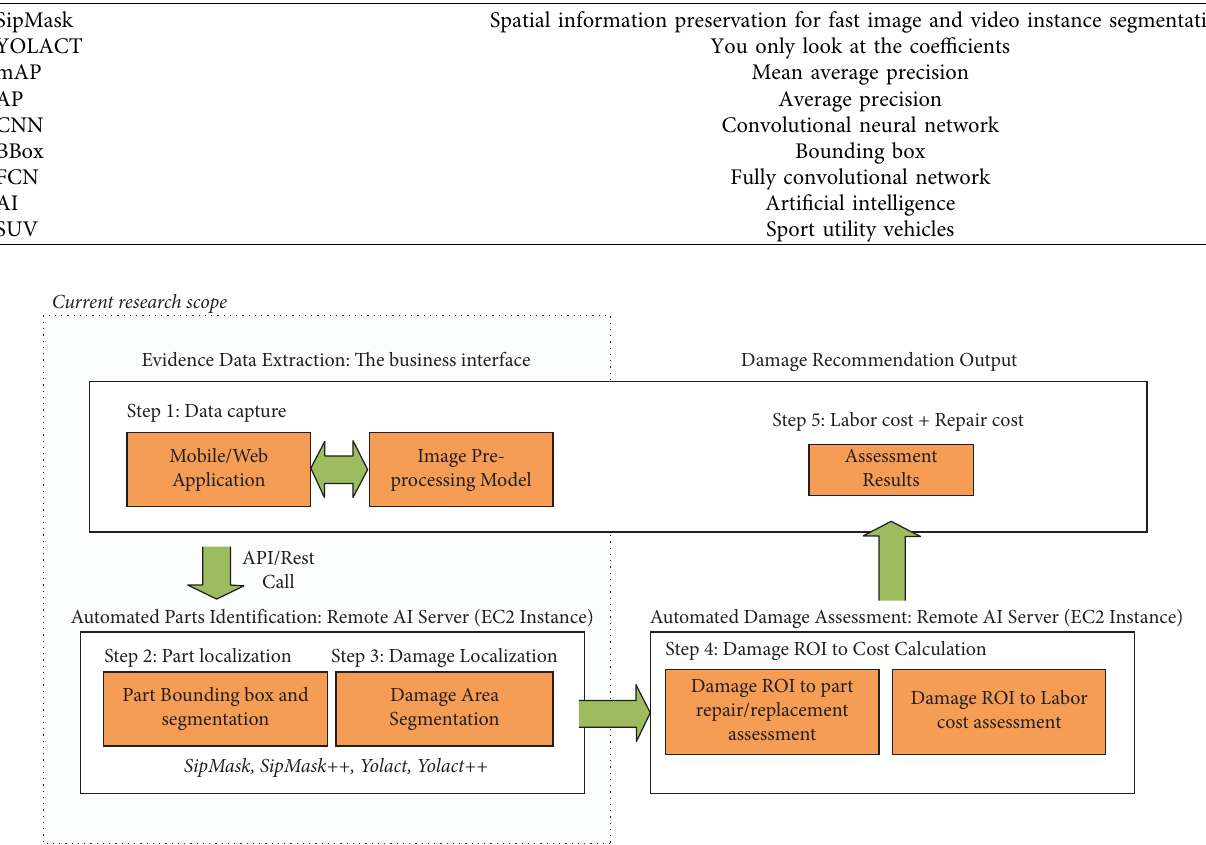
Figure 1: Description of the scope of research presented as well as the overall car damage assessment use case.